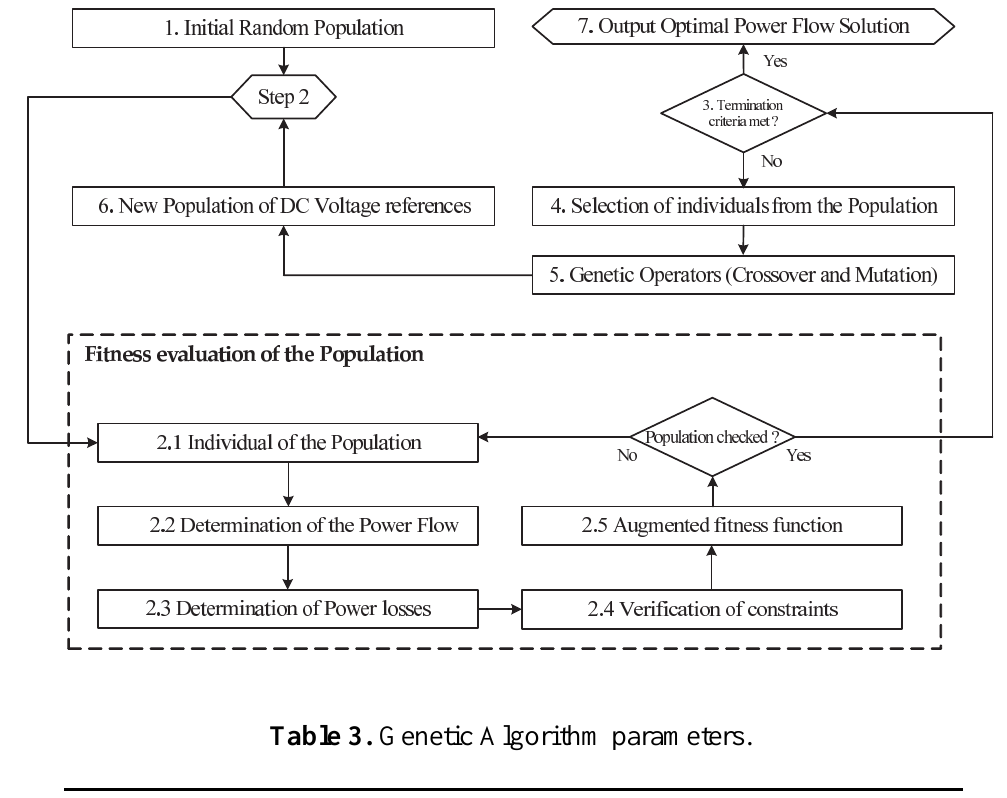
Figure 8. Flowchart of the Genetic Algorithm implemented to solve the load flow of the MTDC grid.